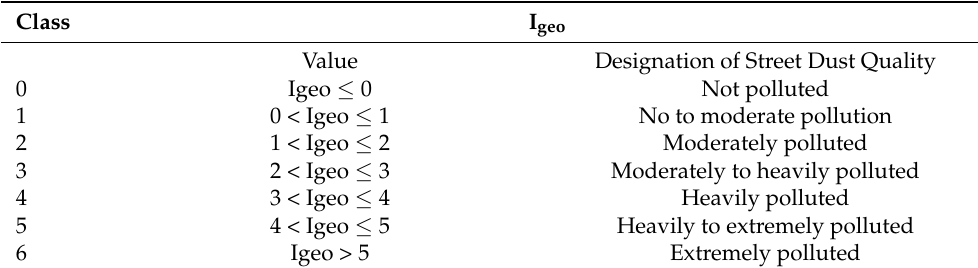
Table 2. Classes of Igeo in Relation to Pollution Levels and Enrichment, respectively.